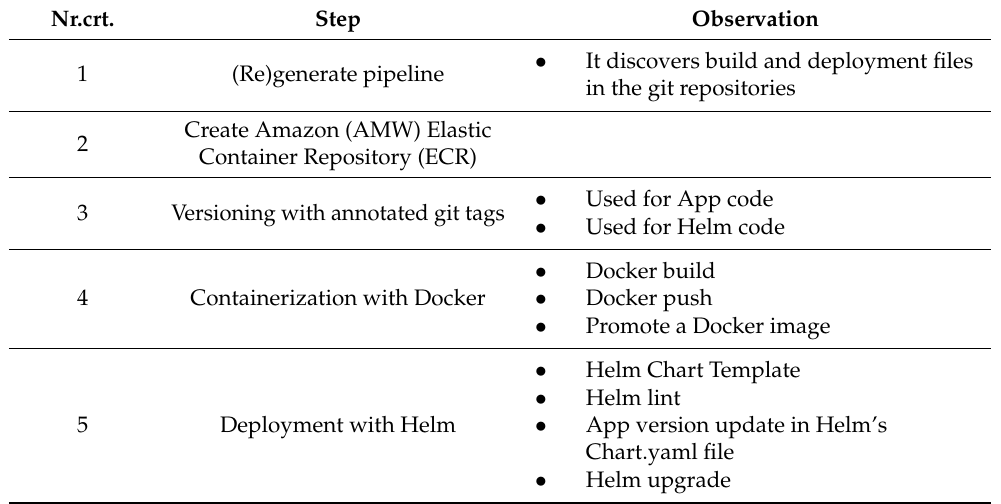
Table 1. Proposed solution necessary